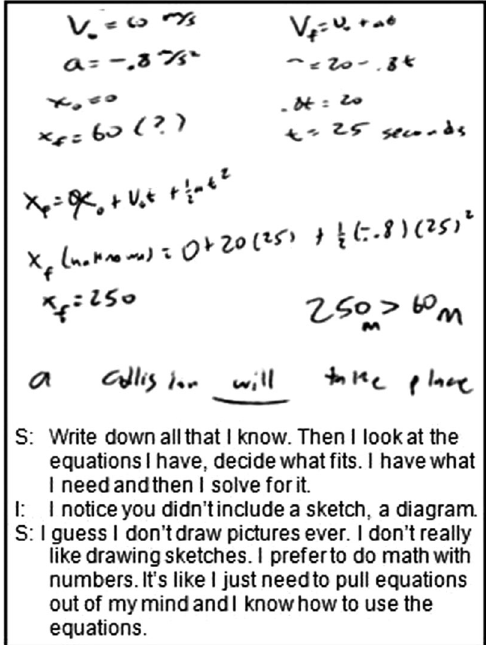
FIG. 7. Solve value from linguistic representation (question